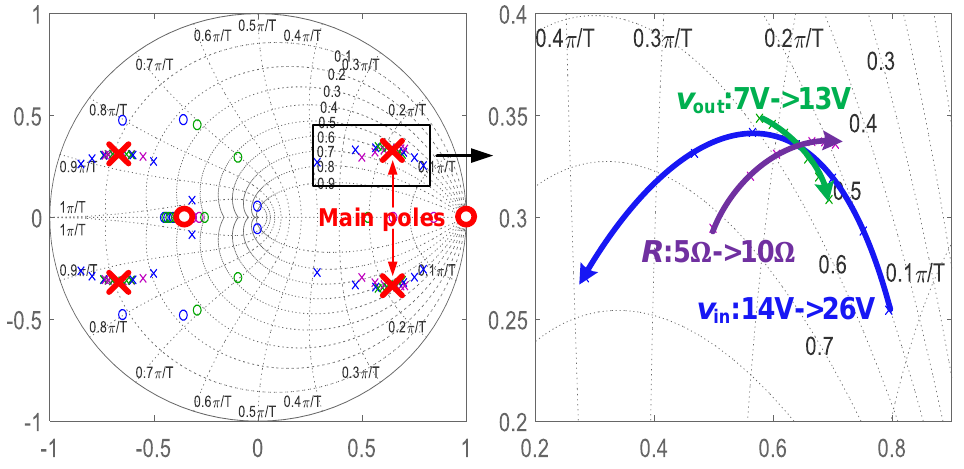
Figure 10. Zeros and poles of F vg ( z ).